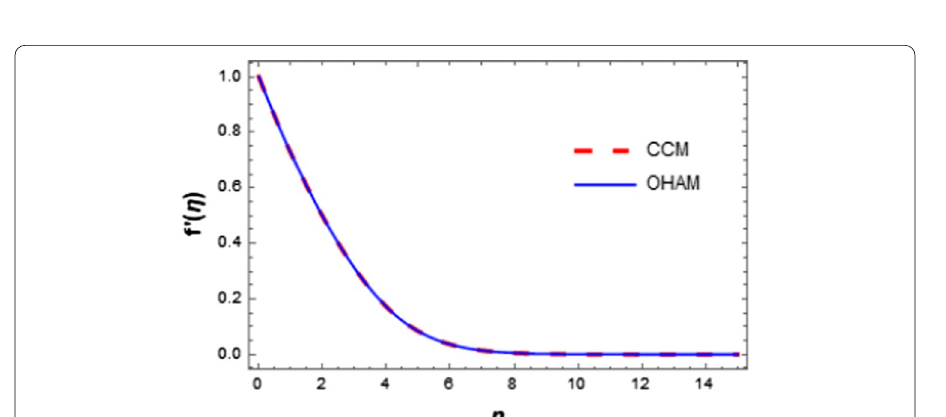
Fig. 3 Comparison of the velocity profile obtained using and CCM and OHAM